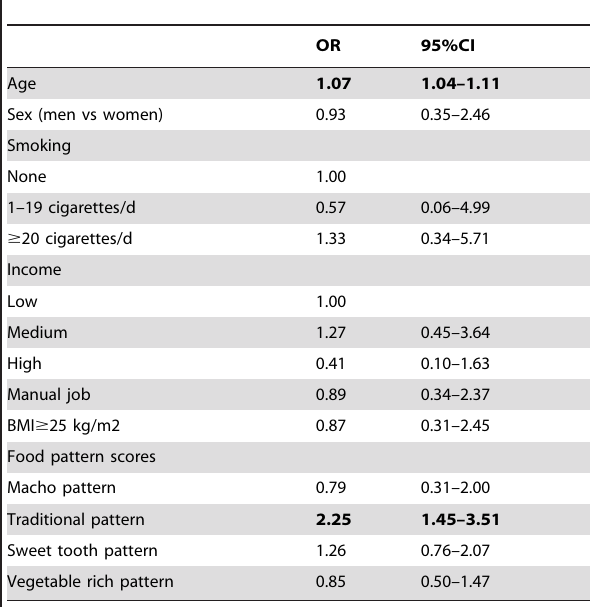
Table 4. Lifestyle and sociodemographic factors associated with asthma in Chinese adults (Jiangsu Nutrition Study)